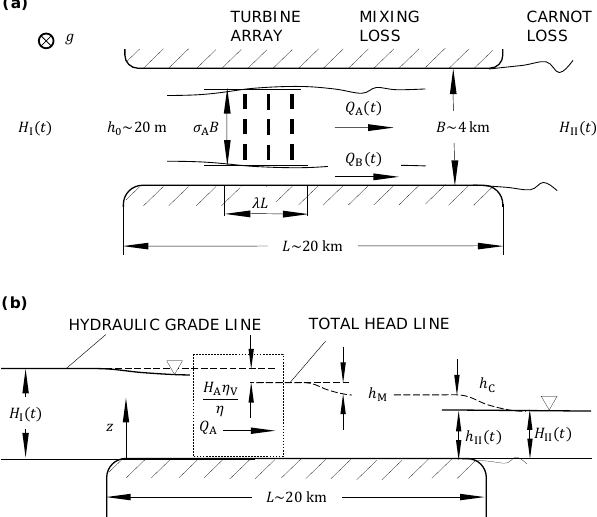
Fig. 4. Schematic of a turbine array covering the width σ A B and length λL of the tidal channel; downstream of the turbine array the mixing of array volume flow Q A ( t ) and bypass volume flow Q B ( t ) = Q ( t ) − Q A ( t ) takes place; (a) top view (b) side view of the